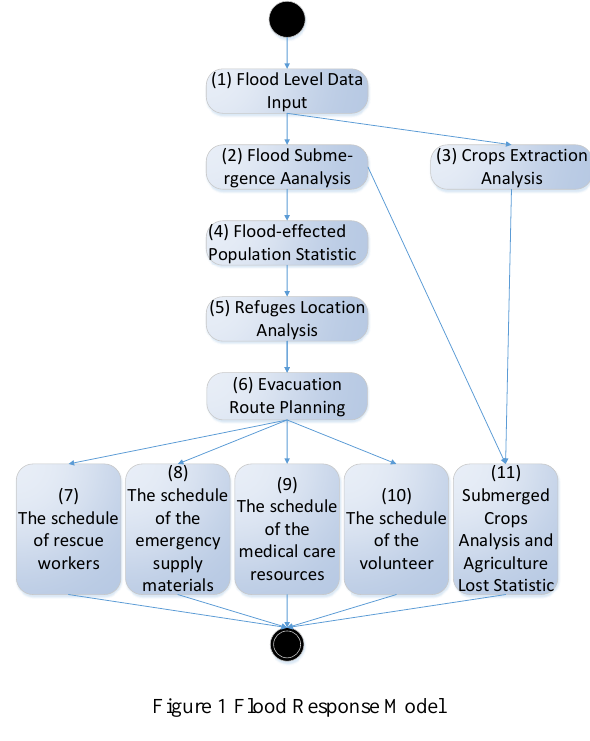
Figure 1 Flood Response